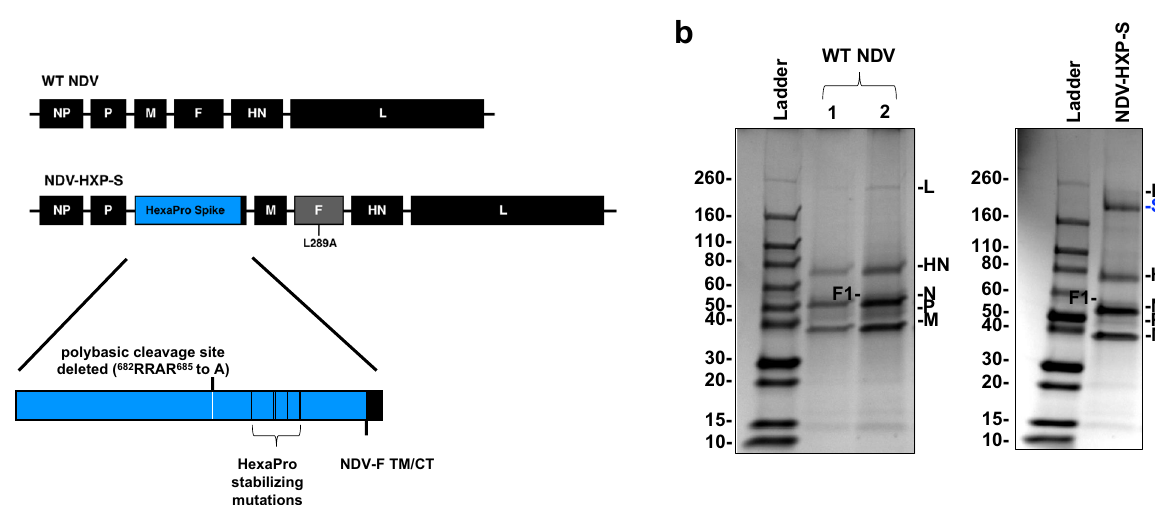
Fig. 1 Design of the NDV-HXP-S construct. a Structure and design of the NDV-HXP-S genome. The ectodomain of the spike was connected to the transmembrane domain and cytoplasmic tail (TM/CT) of the F protein (blue: the ectodomain of the spike; black: NDV components; gray: NDV F gene with L289A mutation). The original polybasic cleavage site was removed by mutating RRAR to A. The HexaPro (F817P, A892P, A899P, A942P, K986P, and V987P) stabilizing mutations were introduced. The sequence was codon-optimized for mammalian host expression. b Protein staining of NDV-HXP-S. WT NDV as well as NDV-HXP-S were partially puri fi ed from the allantoic fl uid through a sucrose cushion and resuspended in PBS. In all, 5 µ g (1) and 10 µ g (2) of the WT NDV, as well as 10 µ g of NDV-HXP-S were resolved on 4 – 20% SDS – PAGE. The viral proteins were visualized by Coomassie Blue staining (L, S[Blue], HN, N, P, and M). A representative image out of more than three independent experiments is